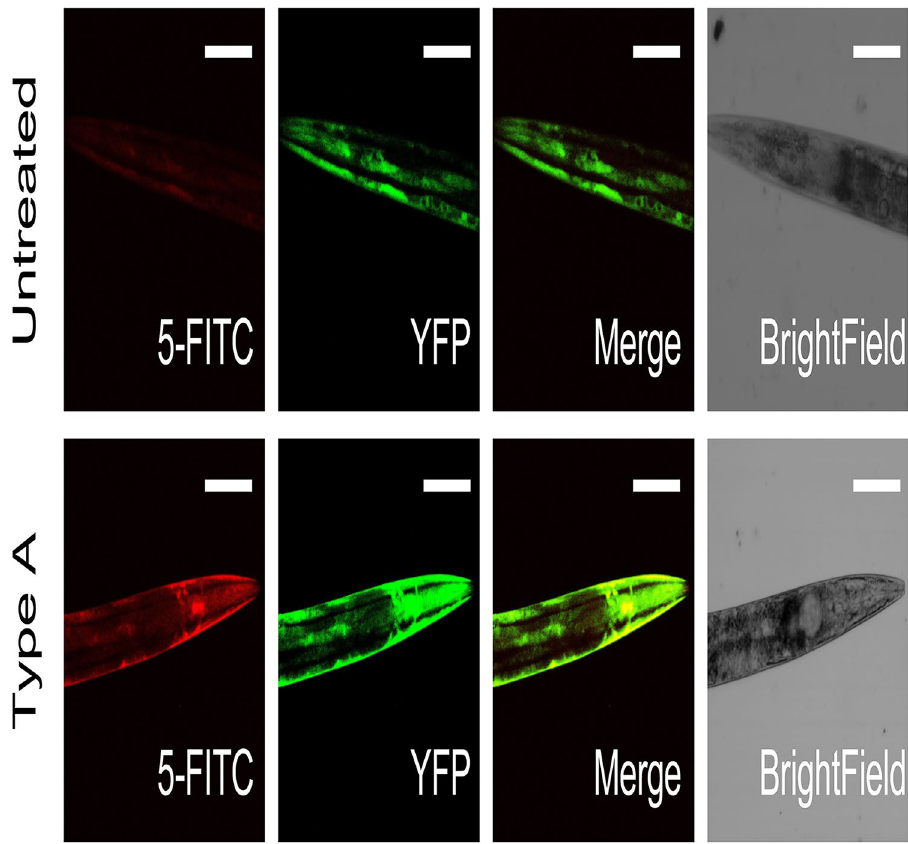
Figure 4. Confocal microscopy analysis of HypF-N type A oligomer co-localisation with muscle cells. Analysis by confocal microscopy of worms expressing YFP in the body wall muscle cells 46 left untreated (top panels) or exposed to 12 µM of type A oligomers (bottom panels). 300 wild-type worms were exposed over a period of 16 h, after which confocal microscopy images were acquired; horizontal bars indicate 80